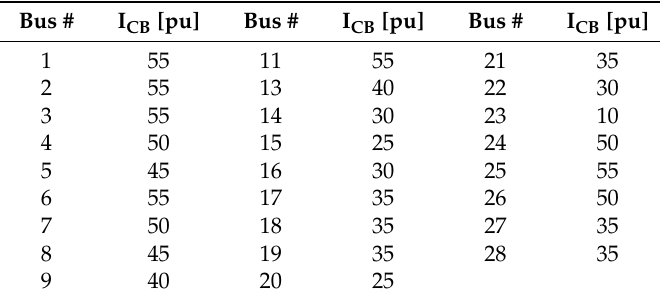
Table 9. Circuit breaker limits in Case 2.